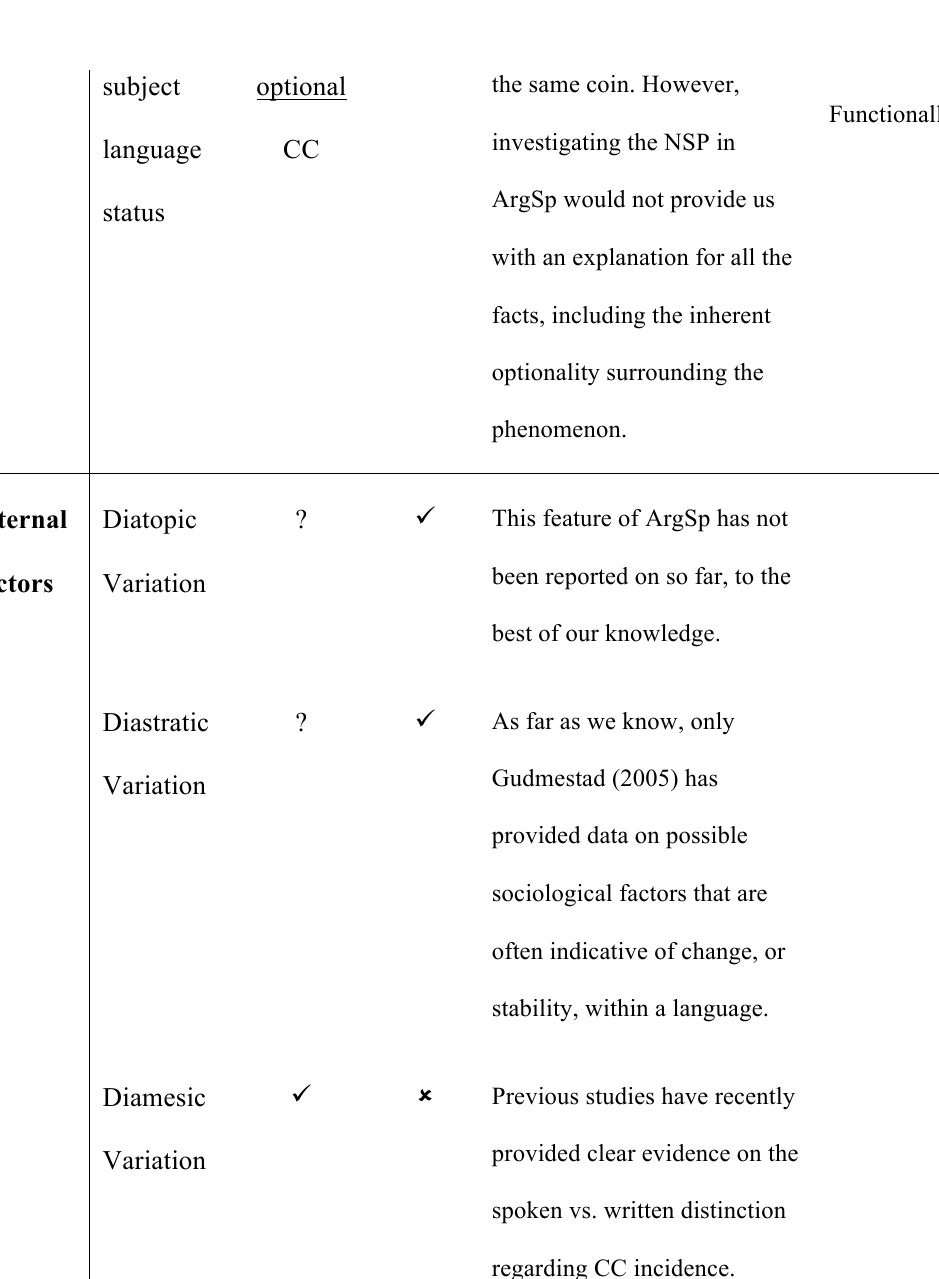
Table 1 . Summary of triggers outlined in previous study of CC, including triggers investigated in the present